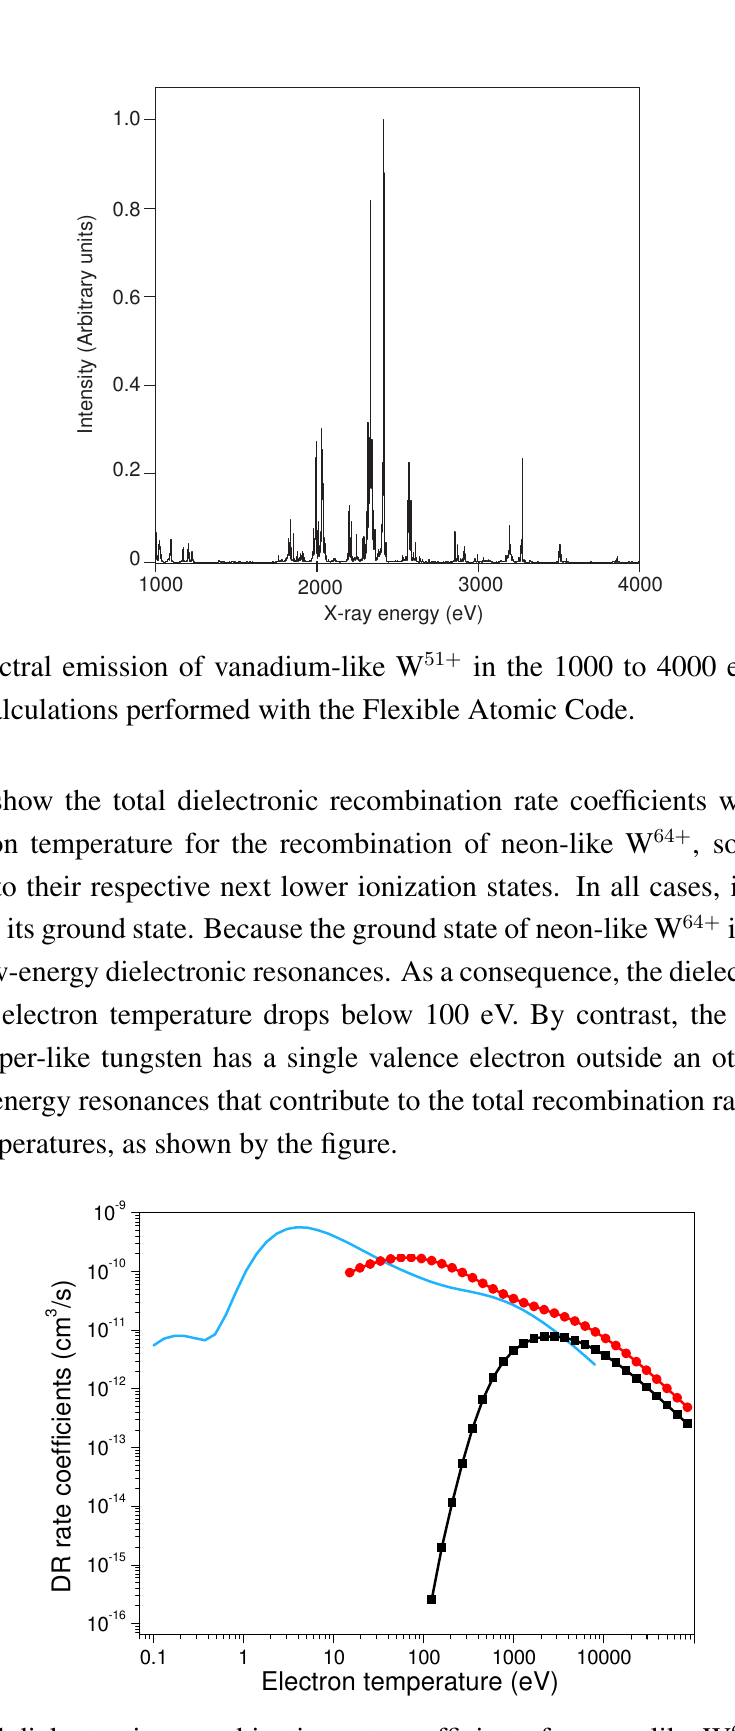
Figure 5. Total dielectronic recombination rate coefficients for neon-like W 64+ (black trace with solid squares), sodium-like W 63+ (red trace with solid circles) and copper-like W 45+ (light blue trace) recombining into their respective next lower ionization